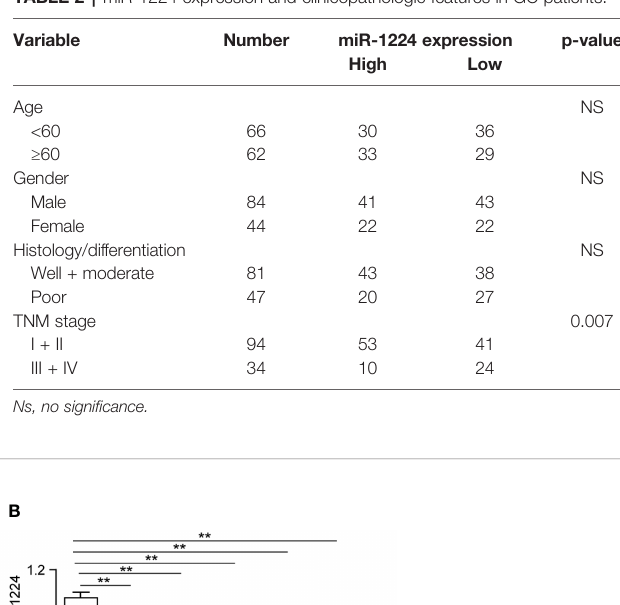
TABLE 2 | miR-1224 expression and clinicopathologic features in GC